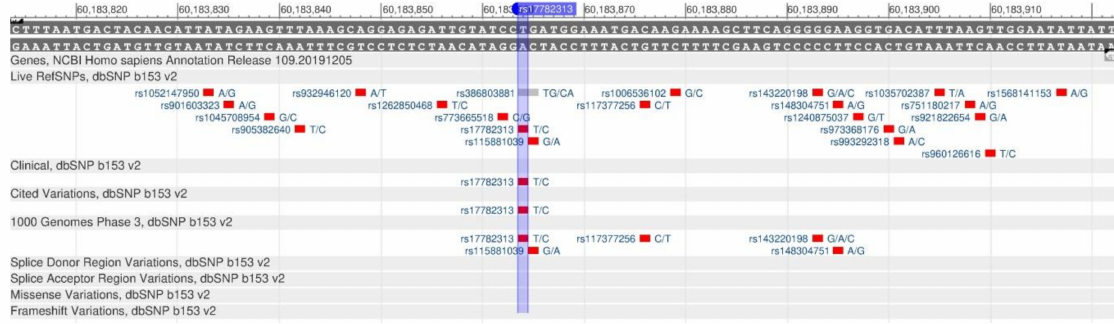
Figure 34. A portion of the MC4R gene (located on the long (q) arm of chromosome 18) containing the oligonucleotide polymorphism rs17782313.